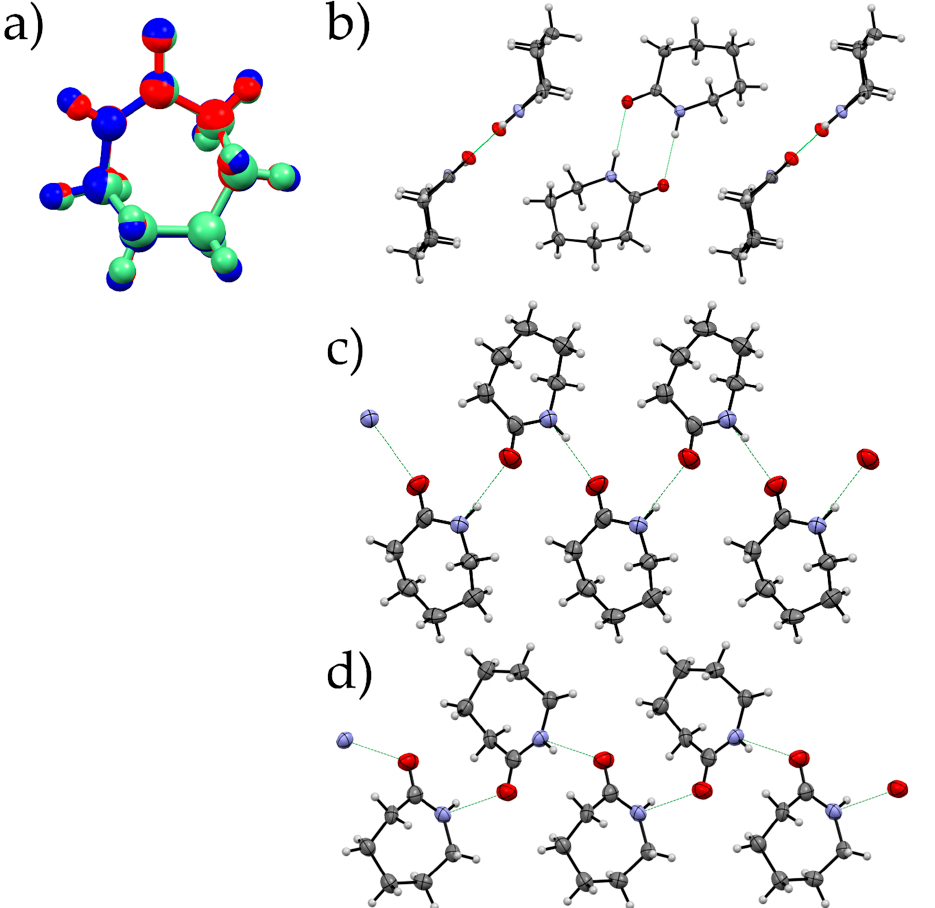
Figure 8. a ) An overlay of caprolactam molecules from three forms at 1.2 GPa created using Mercury [35] (Form I: Red, Form II: Blue, Form III: Green; RMS deviation between I and II 0.0310 and I and